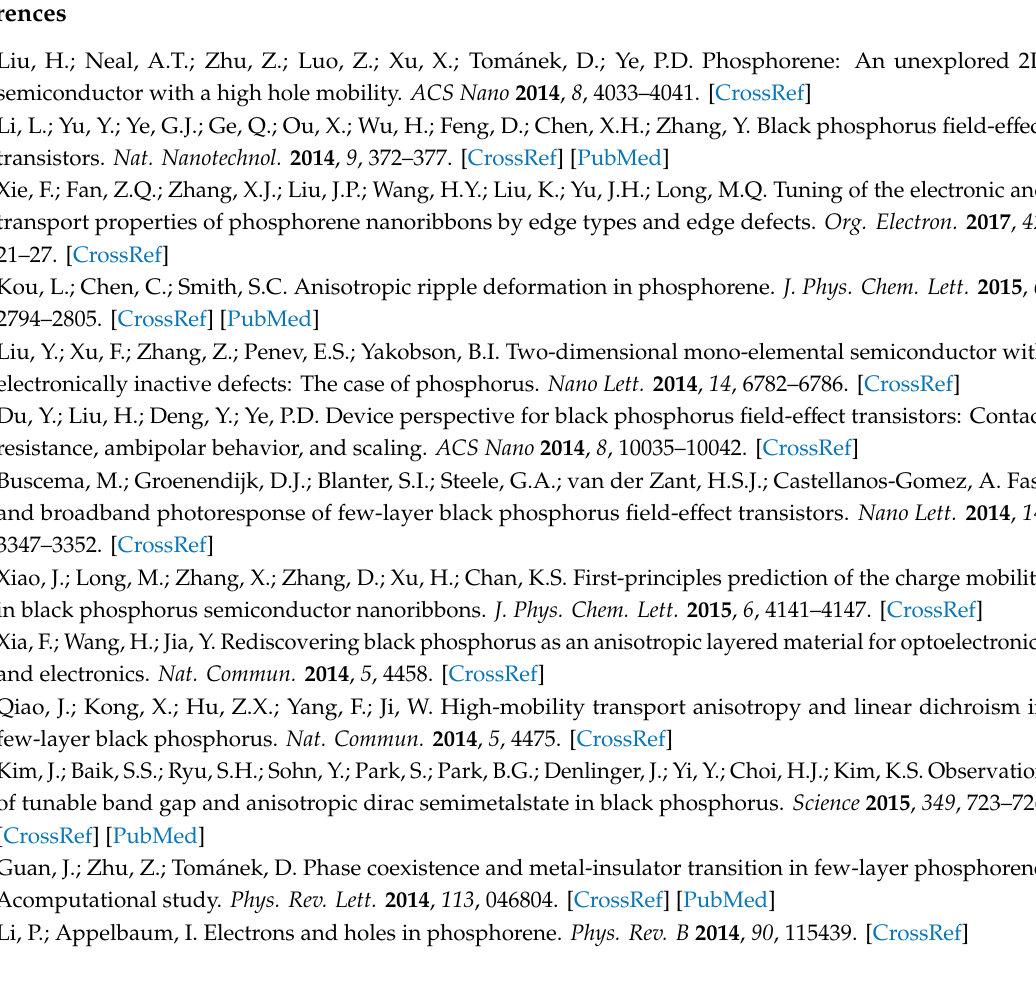
Figure S1: Models of the (a) CO, (b) CO 2 , (c) H 2 , (d) NH 3 , (e) NO 2 and (f) O 2 gas adsorbed on the pristine phosphorene. The purple, red, gray, blue and white balls represent P, O, C, N and H atoms, respectively. Figure S2: Models of the (a) CO, (b) CO 2 , (c) H 2 , (d) NH 3 , (e) NO 2 and (f) O 2 gas adsorbed on the C doped phosphorene. The purple, red, gray, blue and white balls represent P, O, C, N and H atoms,